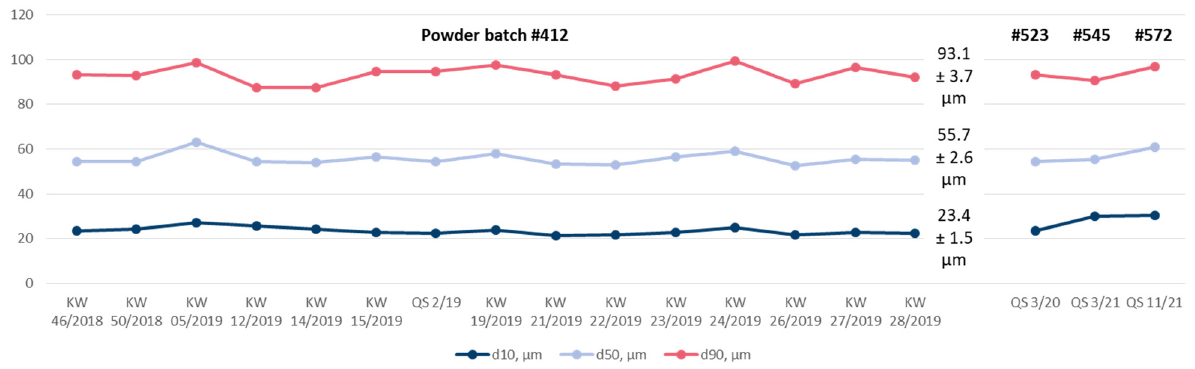
Figure 2. Variability of the particle size distribution obtained in the period of 2020 and 2021 (see text for details).